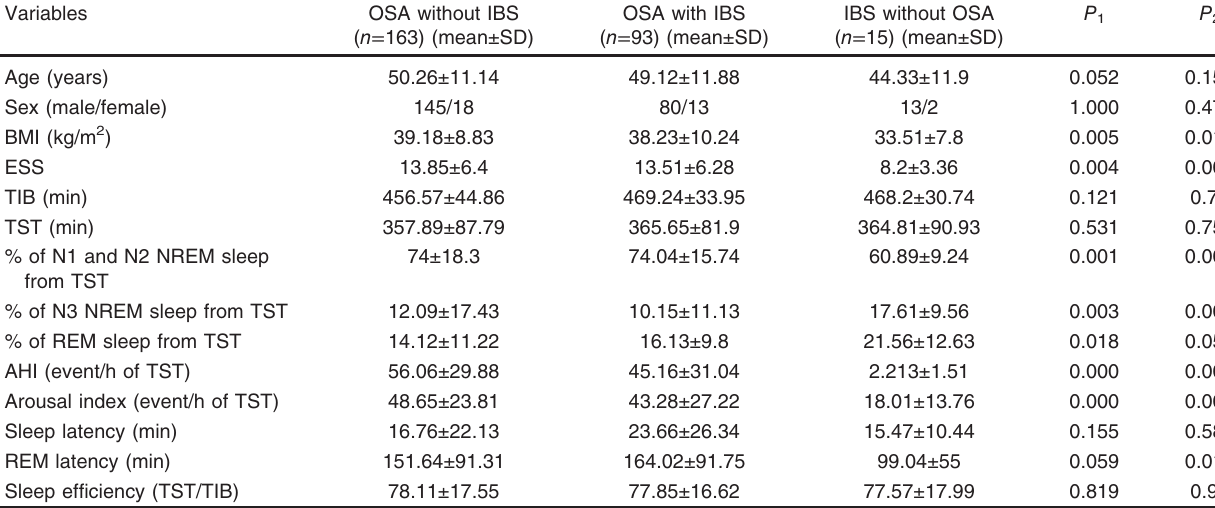
Table 3 Demography, questionnaires, and polysomnographic parameters in obstructive sleep apnea patients and controls